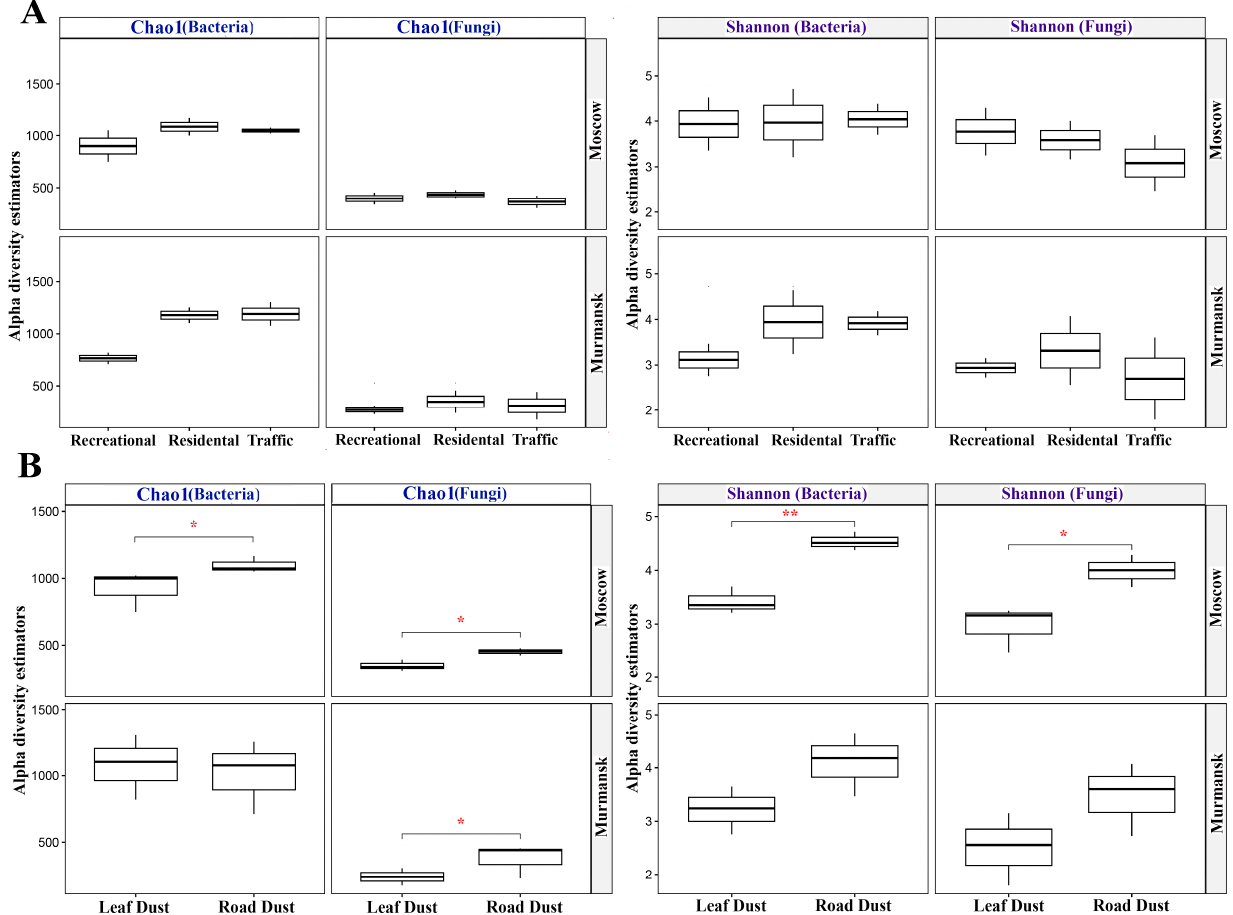
Figure 1. Comparisons of Chao1 richness and Shannon diversity of bacterial and fungal communities between functional zones ( A ) and biotopes ( B ) of Moscow and Murmansk. The horizontal lines show significance levels between groups (* p < 0.05, ** p < 0.01).